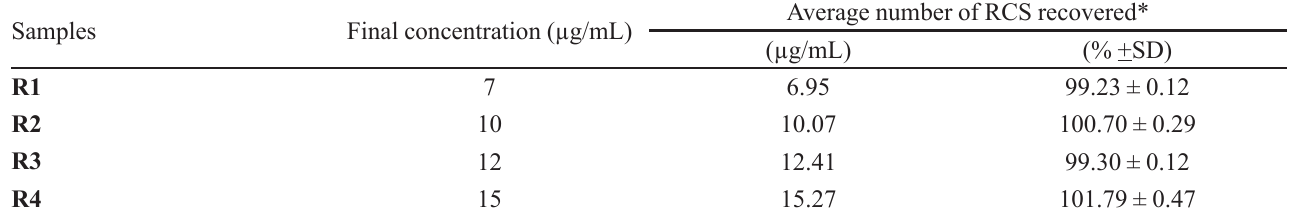
TABLE V - Experimental values obtained for the accuracy test